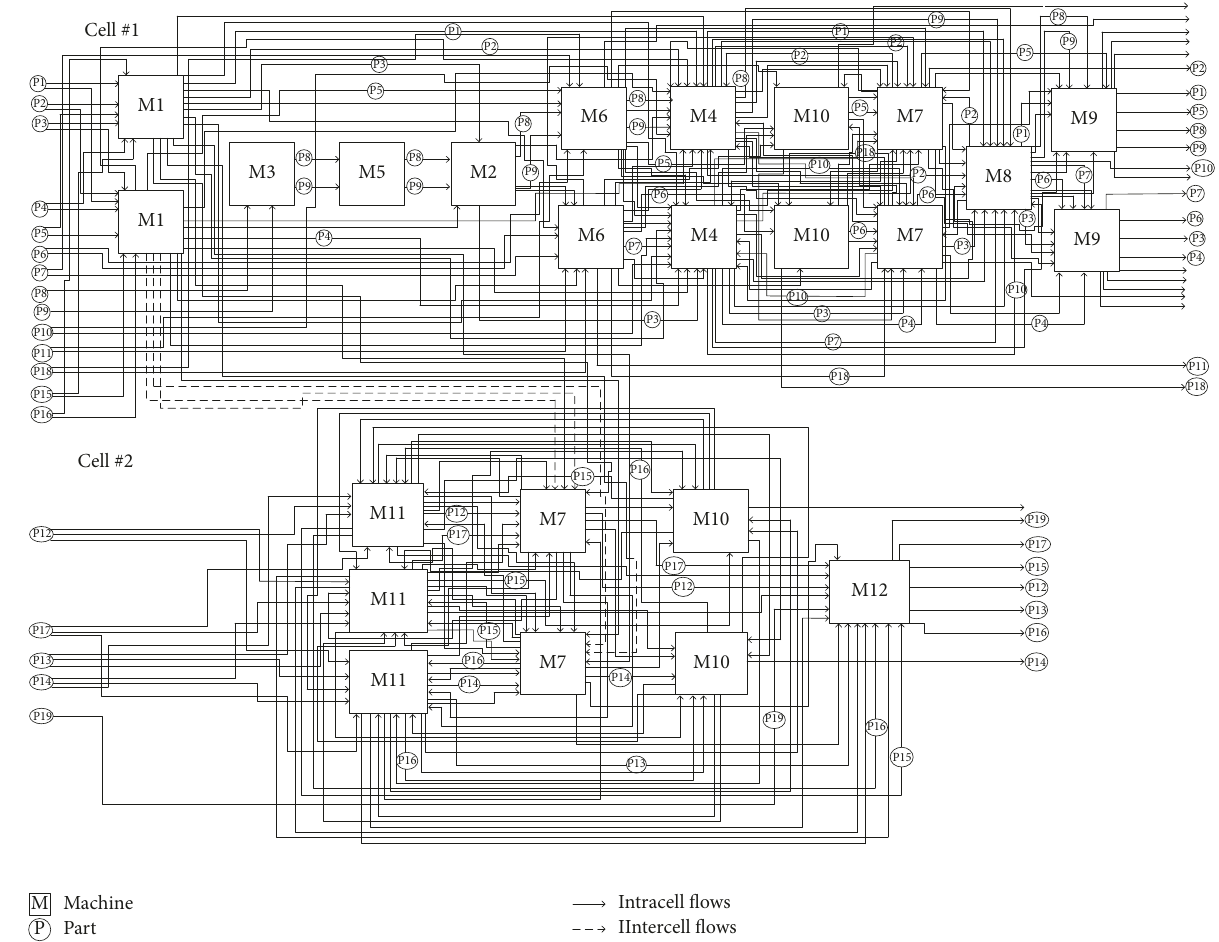
Figure 11: MPC3 and its part flows divided into 2